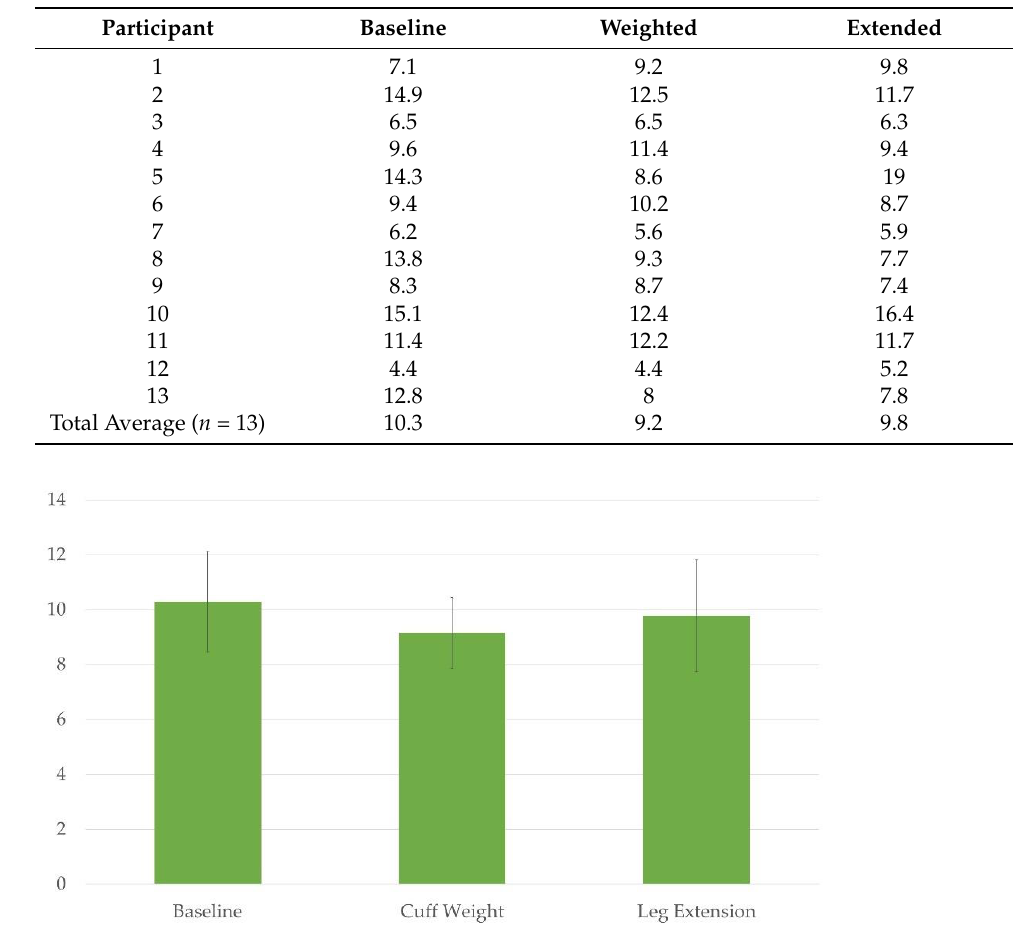
Figure 1. Calculated mean distances from the bullseye (in cm) with standard deviations, for all three conditions ( n = 13).